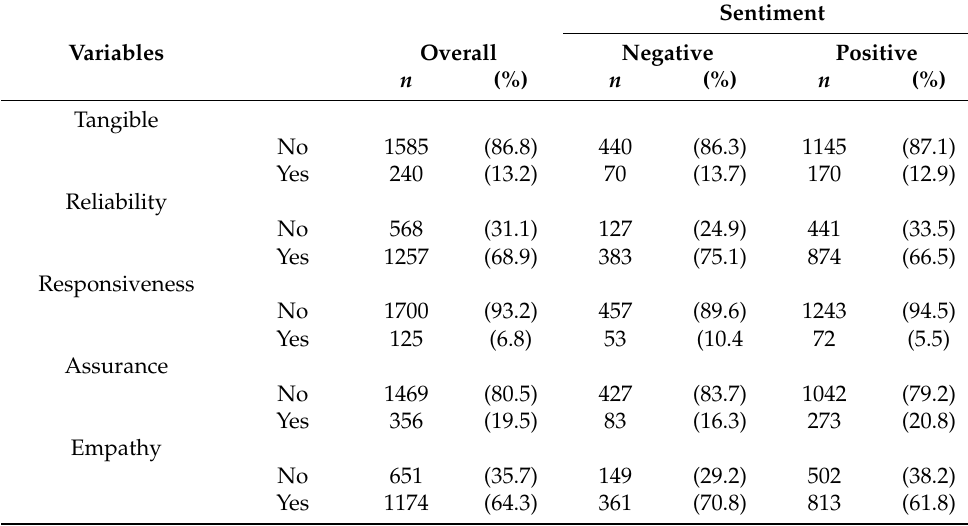
Table 7. SERVQUAL dimensions in Facebook reviews ( n =